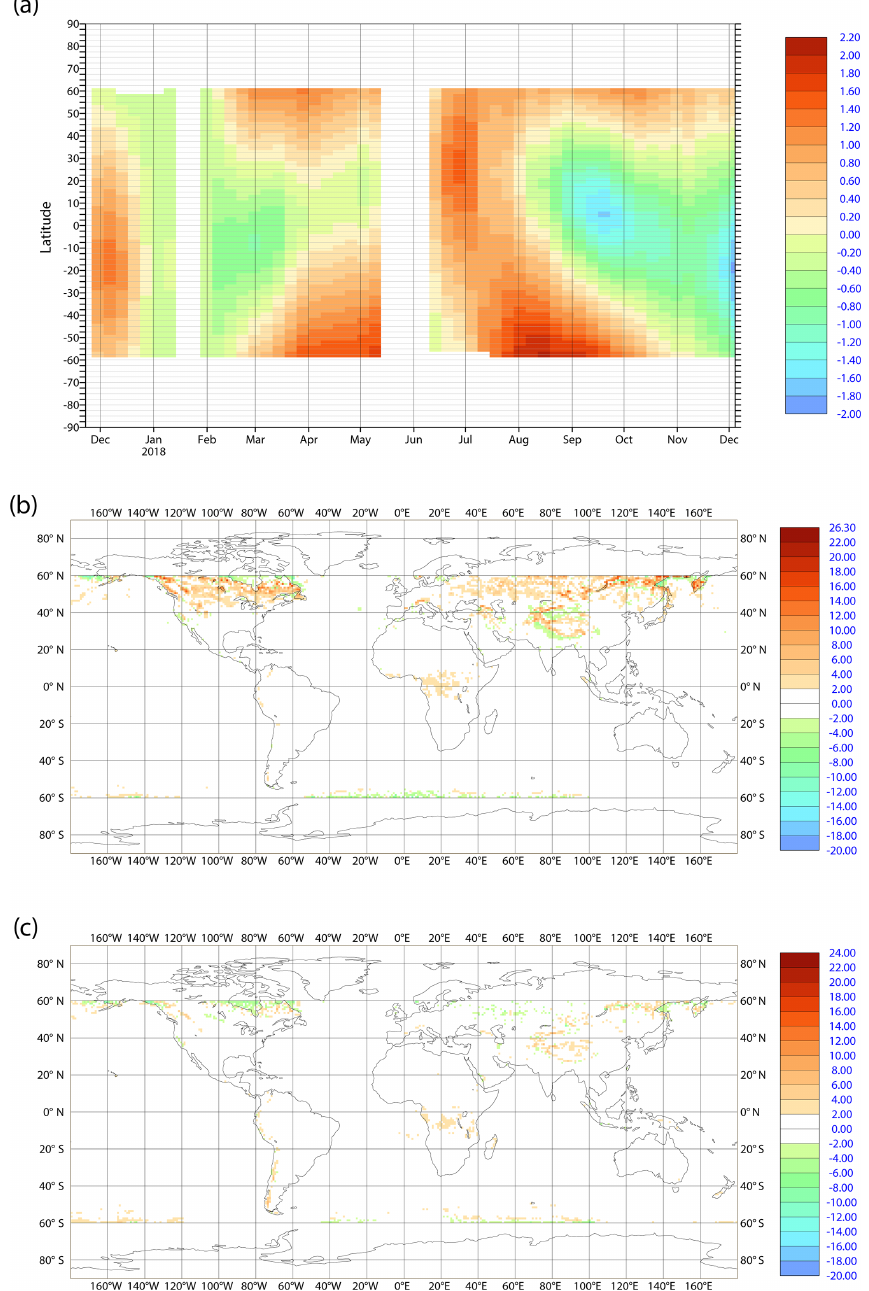
Figure 8. (a) Time series of zonal mean weekly average bias correction applied to TROPOMI TCO3 for the period 26 November 2017 to 30 November 2018 and mean bias-corrected analysis departures for (b) FMA 2018 and (c) SON 2018 (compare with Fig. 5). All values are in